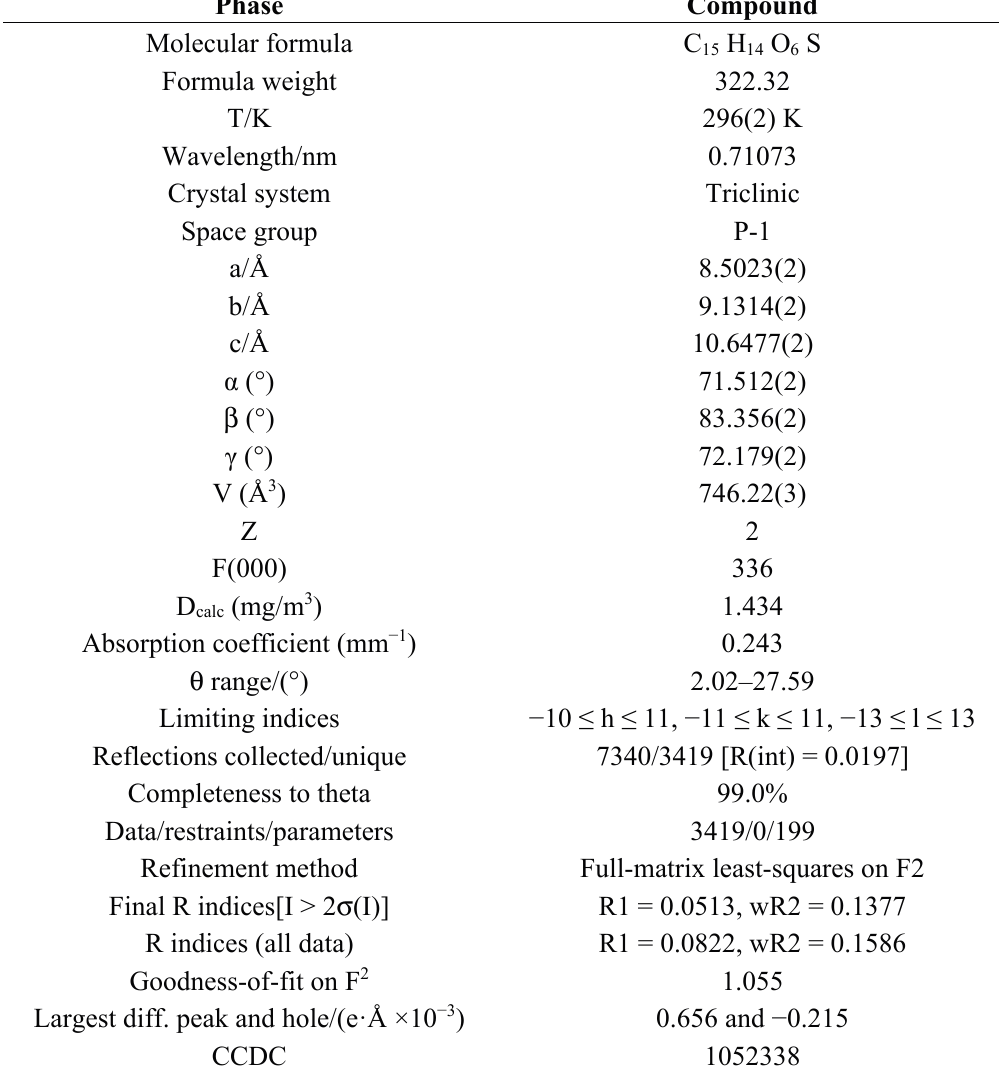
Table 1. Crystallographic data and structure refinement summary for S-CA